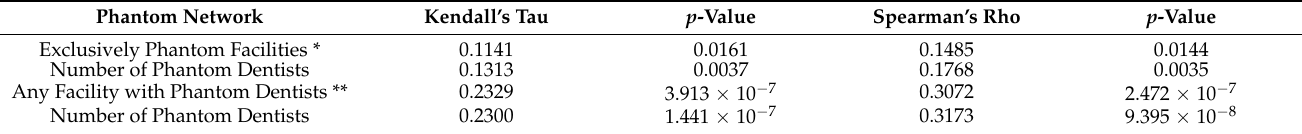
Table 9. Correlation between phantom networks and